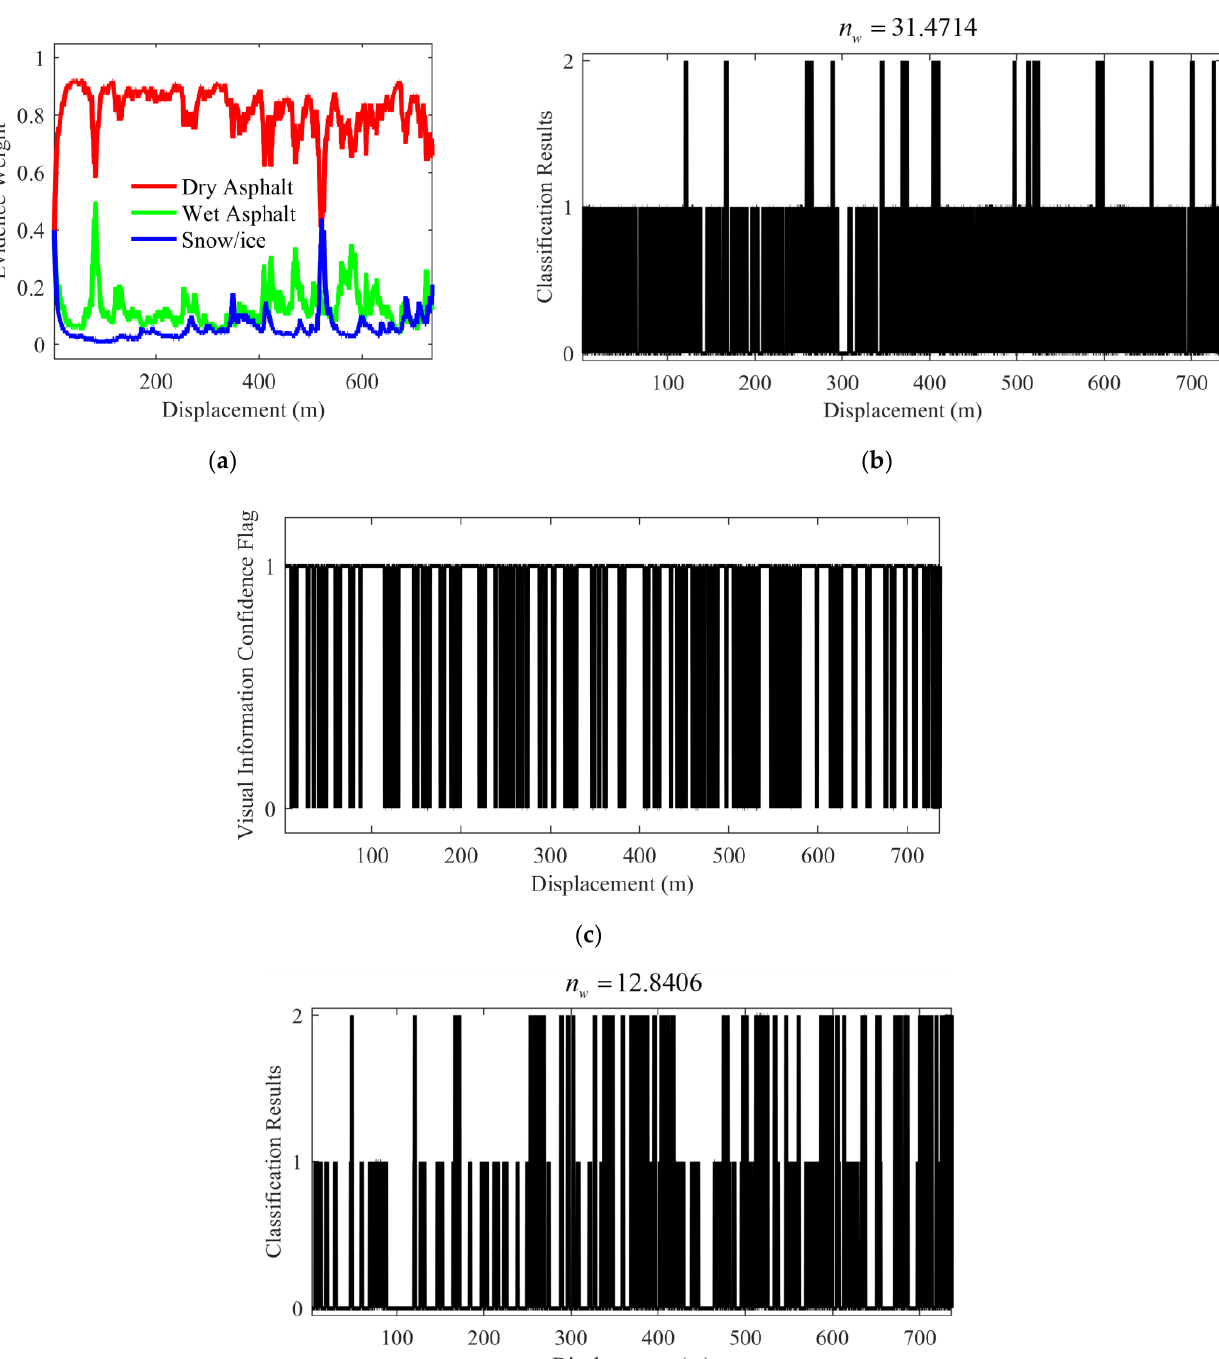
Figure 14. Test results under the scenario with environmental interference (left front wheel). ( a ) Evidence weight distribution; ( b ) Classification results of the IE based on the voting strategy; ( c ) Visual information confidence flag of the IFE; ( d ) Classification results of the IFE. (“0”, “1” and “2” represent dry, wet and snow/ice asphalt road, respectively.).